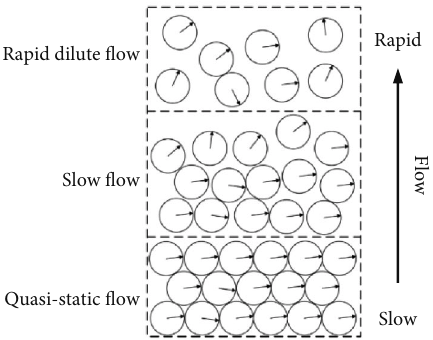
Figure 1: Diagram for partition of particle fl ow.